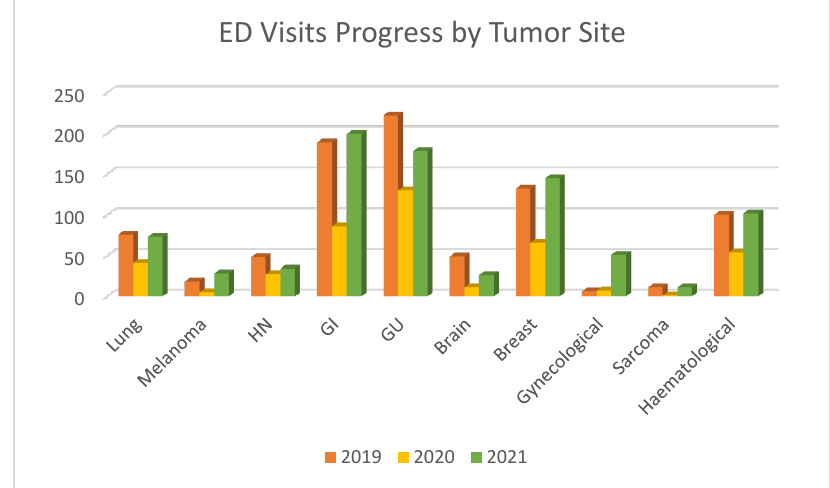
Figure 2. ED visits progress by tumor primary site. increased in 2020 (22.8% vs. 15.5% in 2019) before decreasing again in 2021 (13.8%). Mean- while, those with locally advanced disease had a reduction in ED visits in 2020 (24.9% vs. 33.5% in 2019; p = 0.020) and returned to 36.8% in 2021 ( p = 0.30). Patients with early-stage disease were found to have similar trends across the three years (51.1% in 2019, 52.2% in 2020, and 49.3% in 2021).